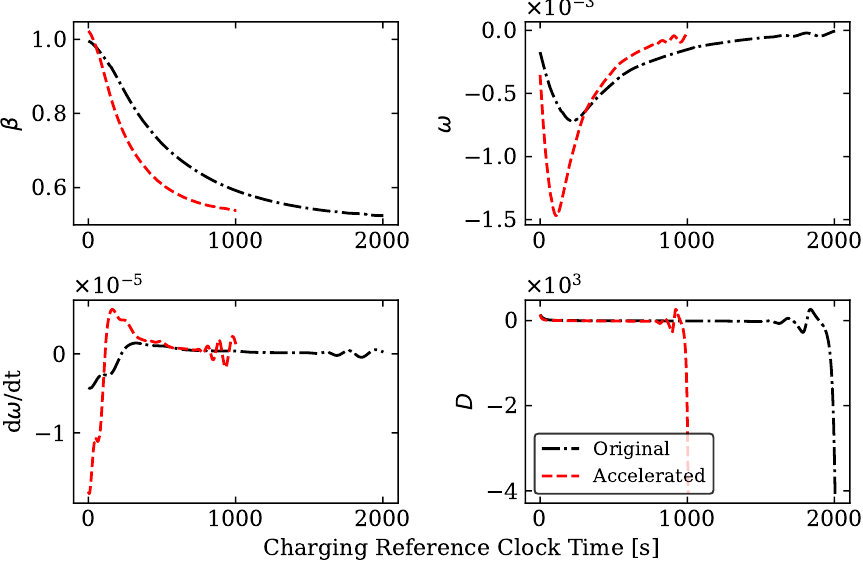
Figure 21. Comparison of discharging mode at the outlet